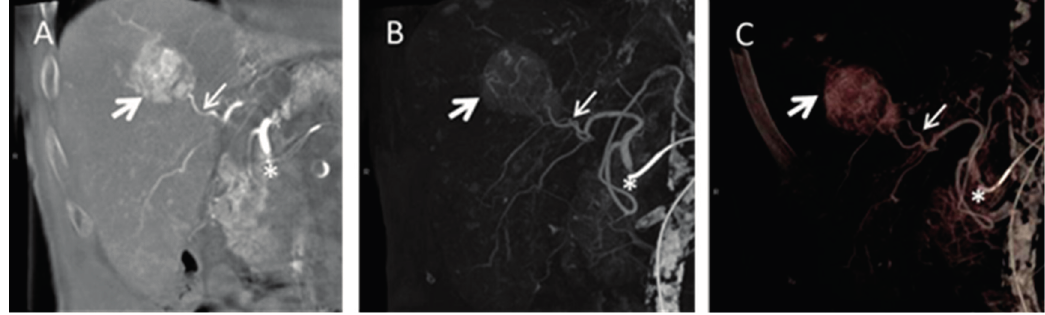
Figure 8. Cone beam computed tomography (CB CT) gained during transarterial chemoembolization (TACE). Coronal multiplanar reconstruction ( A ), coronal maximum intensity projection; ( B ) and volume rendering technique; ( C ) are presented. The tumor volume is marked by the big white arrow and the tumor feeding vessel is marked by a smaller white arrow. The asterisk marks the catheter position in the common hepatic